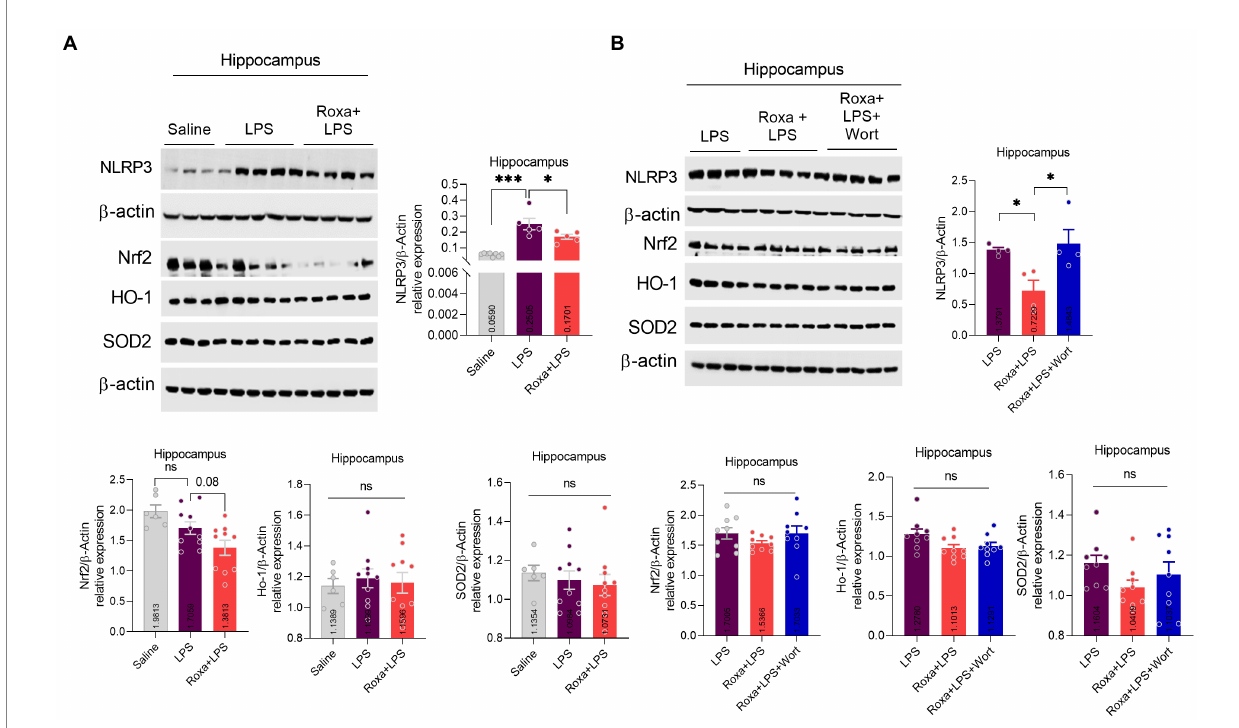
FIGURE 5 Roxadustat reduced NLRP3 level in the presence of LPS. (A,B) Representative immune blots images and bar graphs show the expression of NLRP3, Nrf2, HO-1, and SOD2. All the values were normalized with β -Actin. Image lab software was used for blots quantitative analysis and was analyzed via GraphPad prism. Data were expressed as mean ± SEM, One-way ANOVA, followed by post hoc analysis. p = <0.05 were considered significant, * p < 0.05, *** p < 0.001. ns: